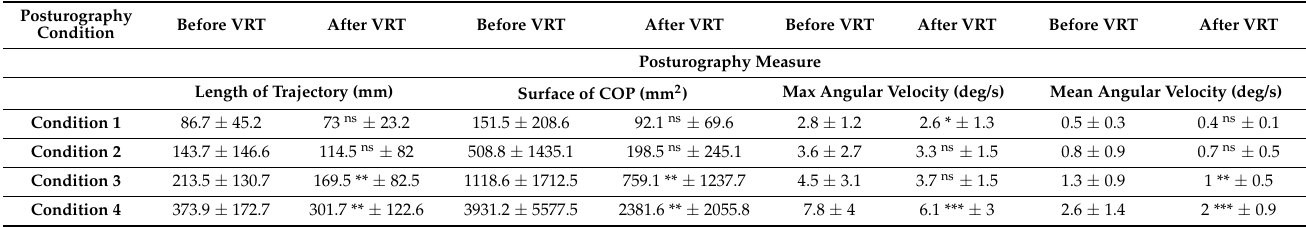
Table 3. Results of instrumental